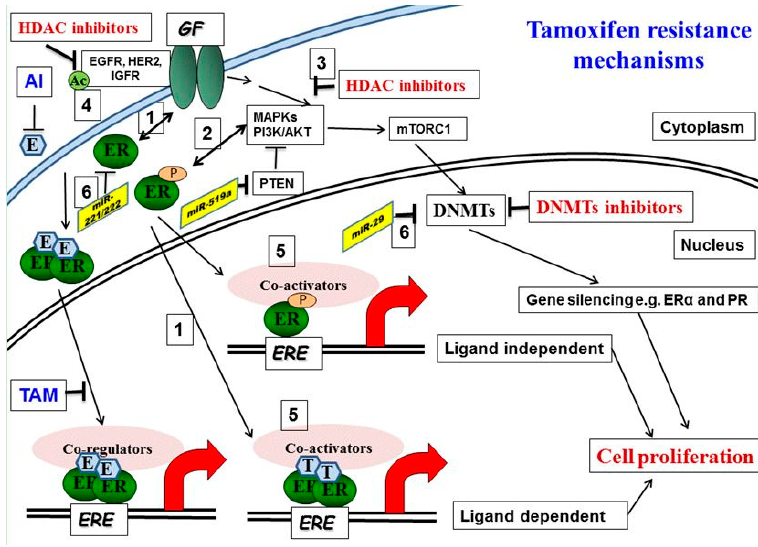
Figure 1. Molecular mechanisms of tamoxifen resistance: (1) Increased bidirectional ER/growth factor (GF) receptor cross-talk converts tamoxifen into an agonist. (2) Activated downstream kinases, including ERK 1, 2 mitogen-activated protein kinase (MAPK) and AKT, phosphorylate both the ER and its accessory proteins. (3) HDAC inhibition reduces phosphorylation of MAPKs and AKT. (4, 5) Acetylation of EGFR promotes receptor tyrosine kinase (RTK) phosphorylation and activation. Corepressor complexes with NCoR Fare inactivated and dismissed from Tam-bound ER-promoter complexes, allowing instead the recruitment of the phosphorylated/activated coactivator complexes with AIB1. This results in an increase in the agonist versus the antagonist activity of tamoxifen on gene transcription. (6) microRNA involved in tamoxifen resistance, miRNA221/222, is upregulated and miR-29 is downregulated in tamoxifen-resistant cells.